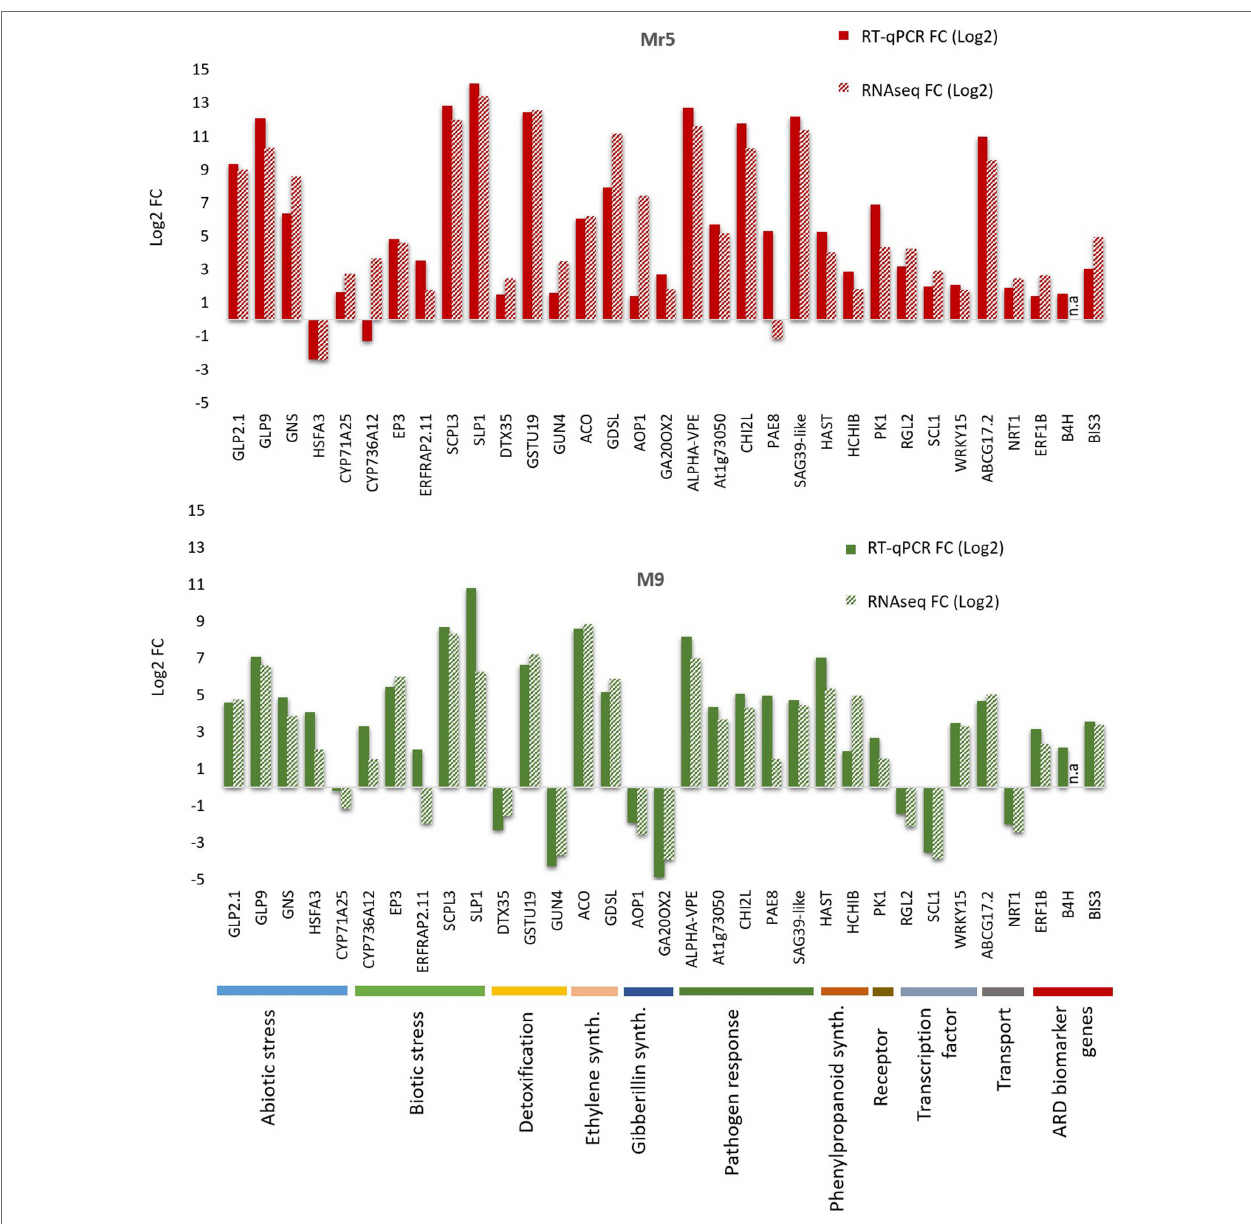
FIGURE 7 | Illustration of the results of the RT-qPCR validation for the selected 30 differentially expressed genes and the three ARD biomarker genes biphenyl synthase 3 ( BIS3 ) , biphenyl 4-hydroxylase ( B4H ) and ethylene-responsive transcription factor 1B-like ( ERF1B ). The 30 DEGs belong to 10 different major functions, as illustrated by the different colors at the bottom of the figure. The 30 DEGs thought to play a potential role in the defense response to ARD were validated for the ARD tolerant apple cultivar Mr5 (red bars) and the susceptible rootstock ‘M9’ (green bars). A highly significant positive correlation ( r = 0.91; p < 0.0001) between the log2 fold change of the RNA-seq and RT-qPCR results was observed. n.a: not